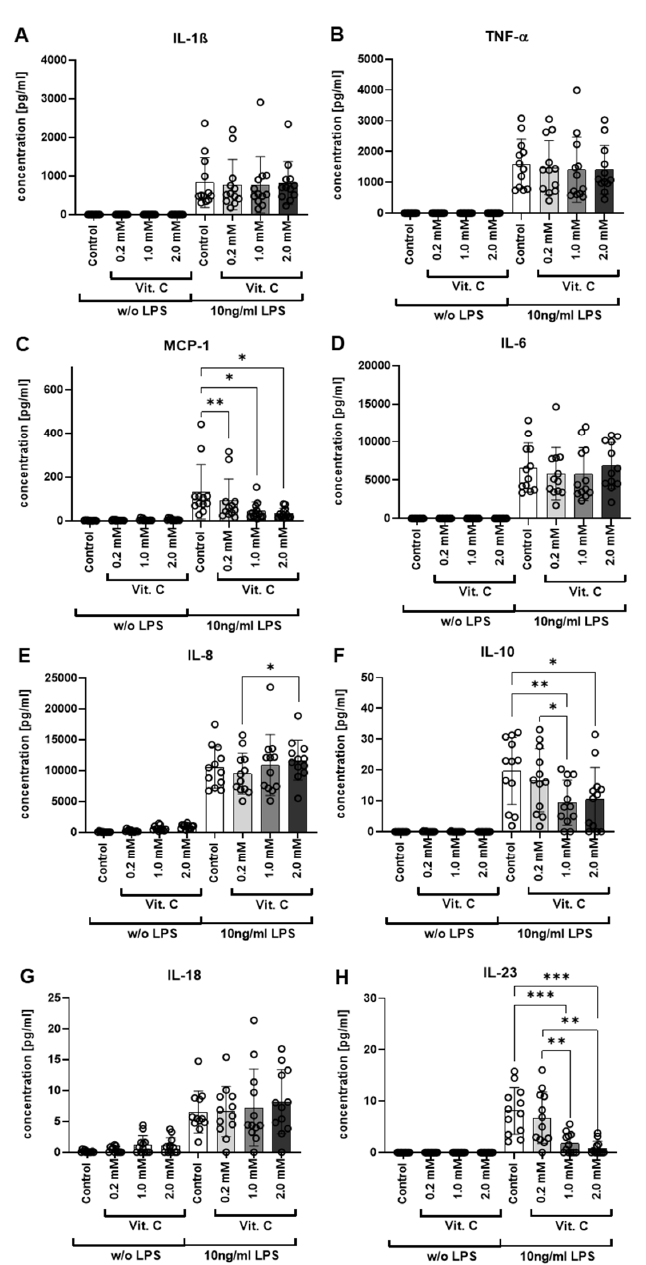
Figure 2. Detailed cytokine secretion analysis after vitamin C treatment. ( A – H ). The secreted cytokines after 6 h treatment were quantified using LEGENDplex TM followed by flow cytometry. An untreated control and three different vitamin C concentrations (0.2–2 mM) were studied, as well as an LPS-treated (10 ng/mL) control and the three vitamin C concentrations under LPS stimulation. Shown are the mean values and standard deviations with one separate data point for each donor, with a measurement in duplicates for each donor. *: p ≤ 0.05; **: p ≤ 0.01; ***: p ≤ 0.001. Additional data analysis stratified according to gender is available as Figure S3. IL = interleukin; LPS = bacterial lipopolysaccharides; MCP = monocyte chemo-attractant protein; TNF = tumor necrosis factor; Vit. C = vitamin C.